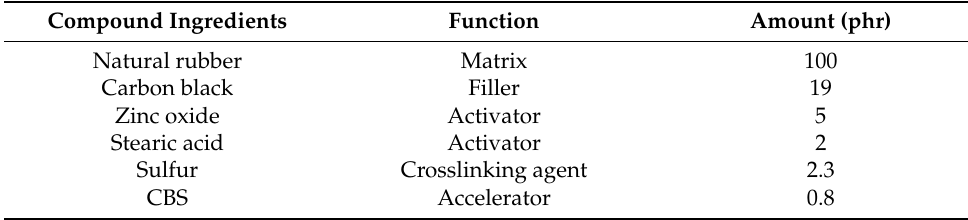
Table 1. Formulation of compound ingredients.